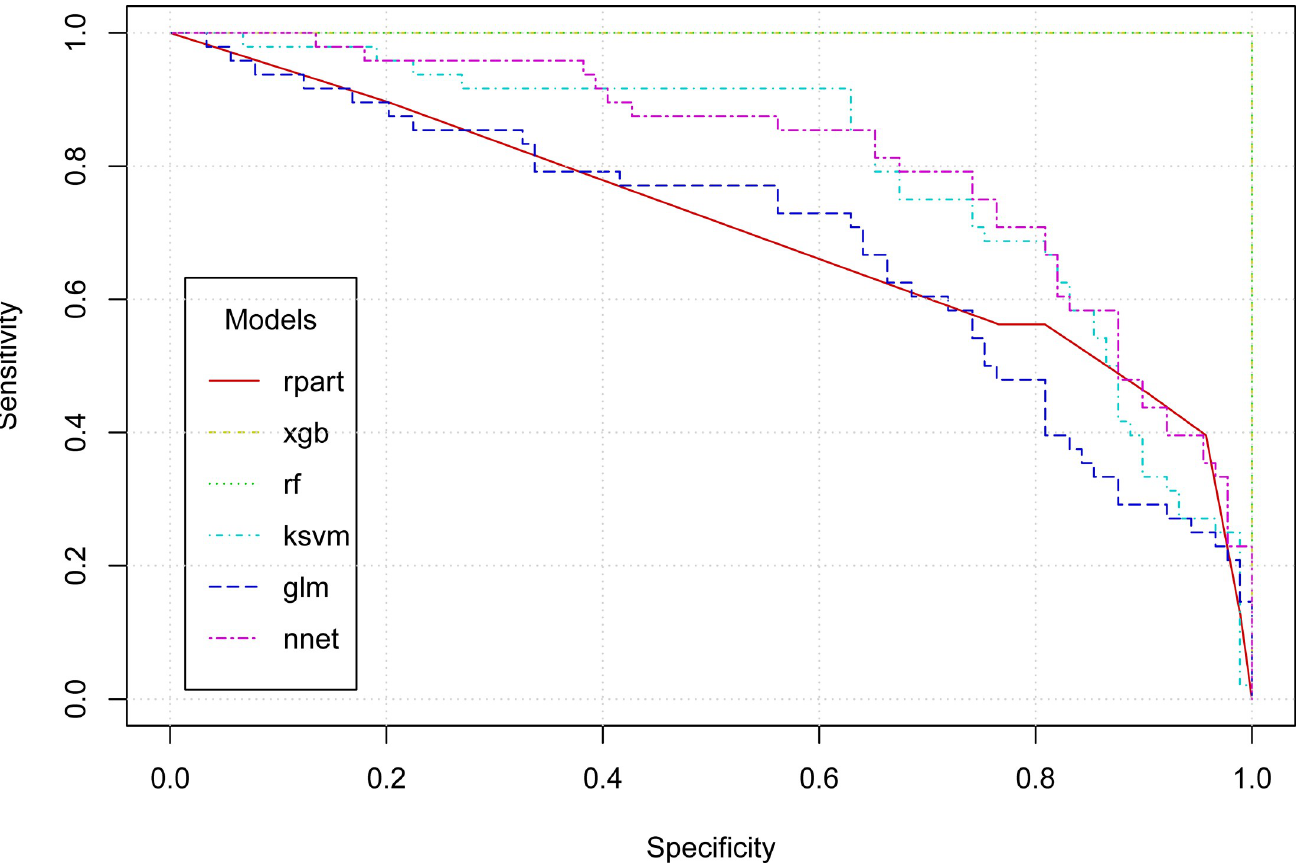
Fig 3. Receiver operating characteristic curves for pneumoconiosis predicted by six machine learning algorithms. We included the prediction variables of age, sex, SMRP, fibulin-3, CEA, and 8-OHdG/creatinine in the model and used six machine learning algorithms to establish a prediction algorithm. Machine learning algorithms use R packages of the decision tree (rpart), extreme gradient boosting (xgb); random forests (rf), support vector machines (ksvm), generalized linear models (glm), and neural networks (nnet). The AUROCs ranged from 0.7 to 1.0.